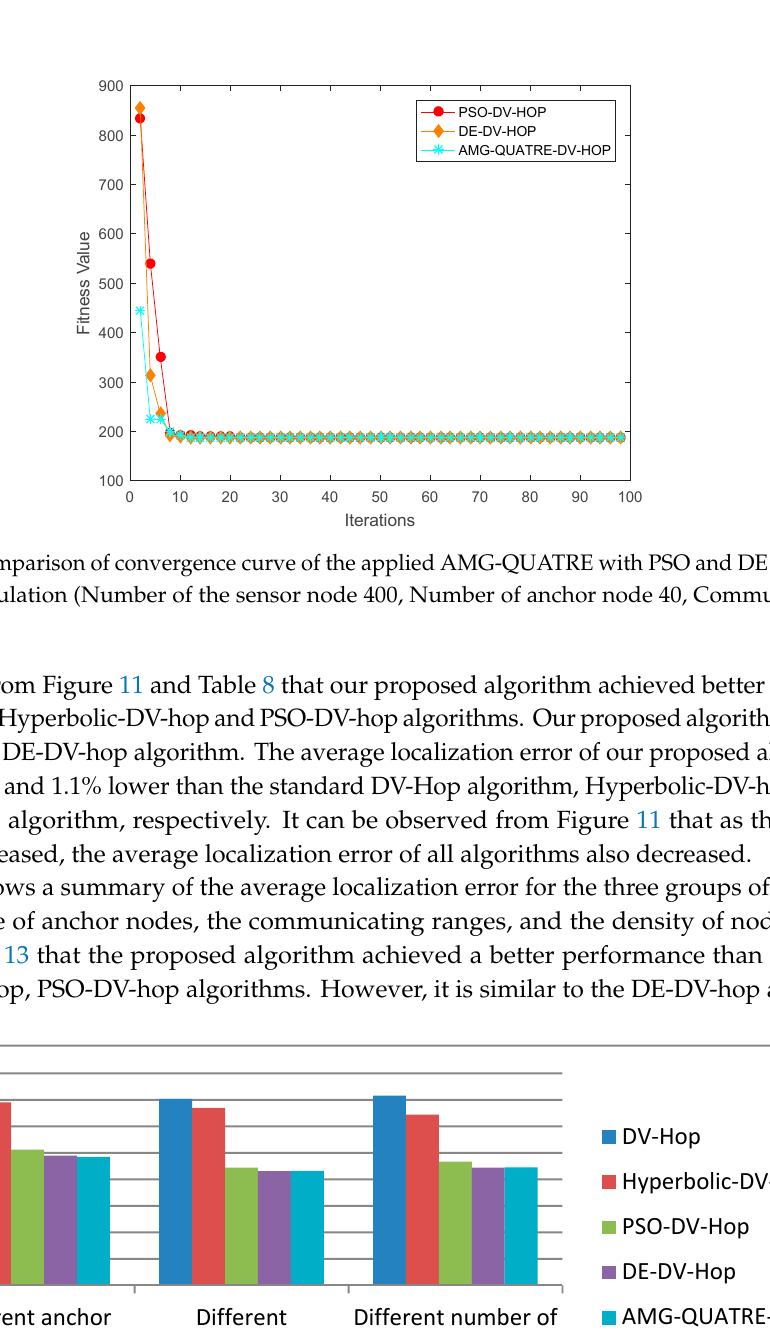
Figure 13. Comparison of average localization error of the applied AMG-QUATRE with the other methods.